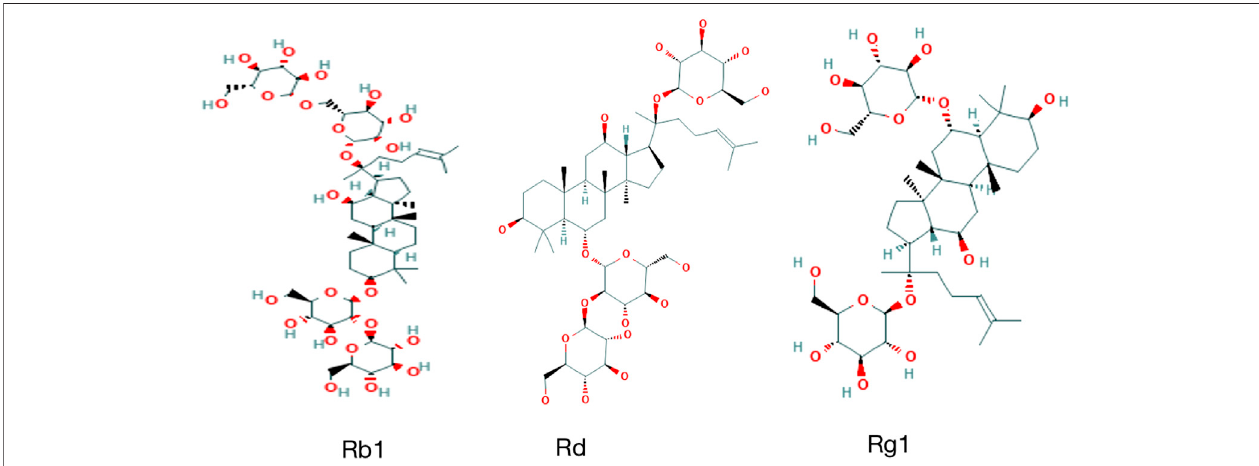
FIGURE 2 | Chemical structure of ginsenosides in this